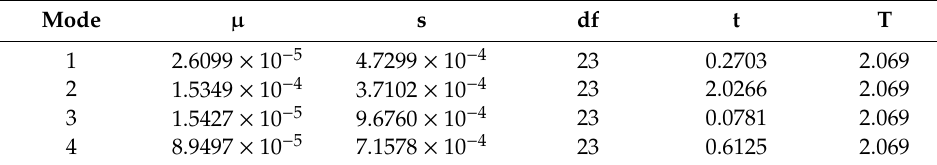
Table 5. Hypothesis test results of the testing